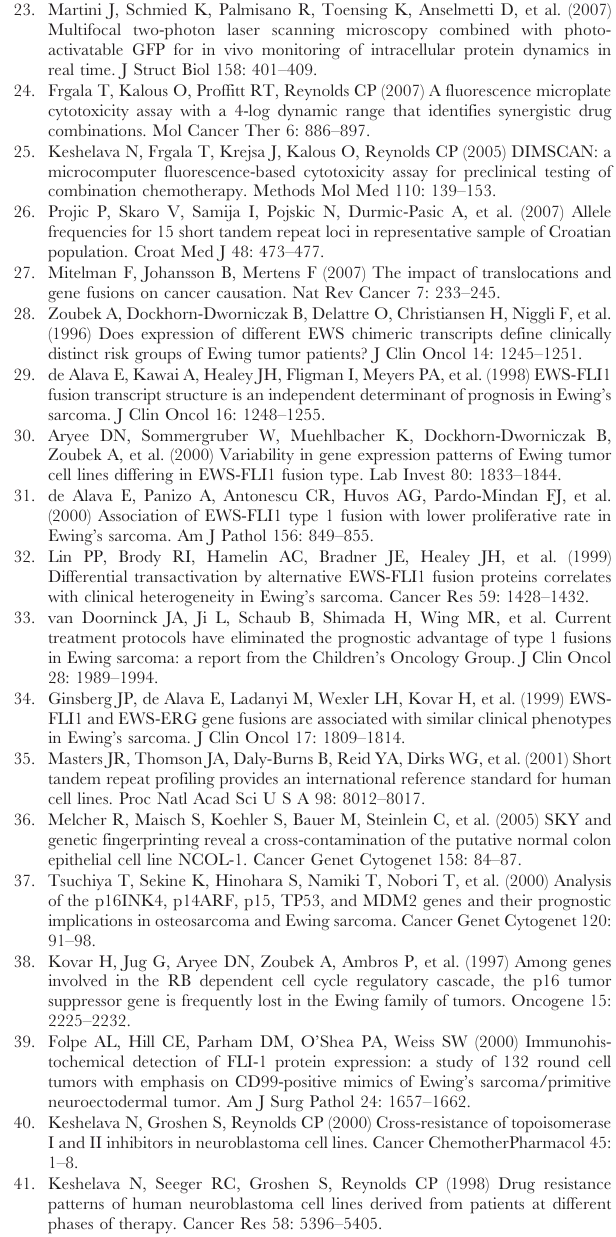
Table S1 PCR Primers. A. Primers used for gene expression. B. Primers used for p53 testing. Table S2 Short tandem repeat (STR) profiles of EFT cell